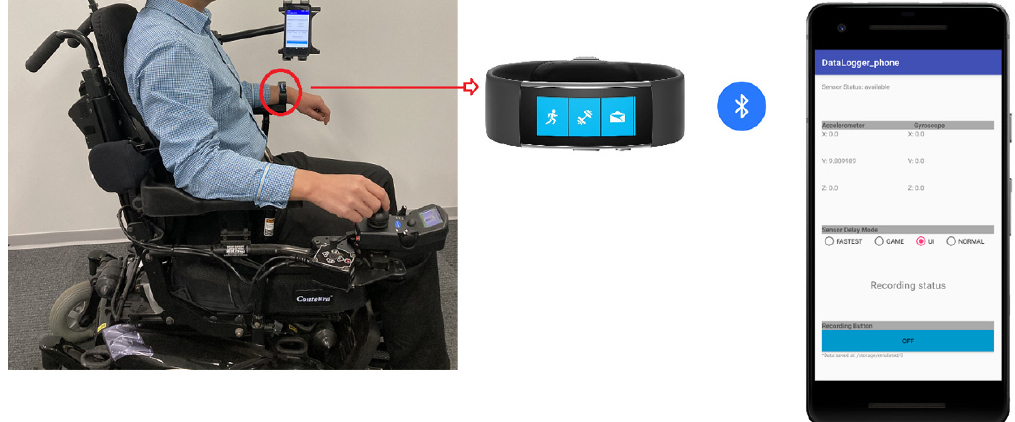
Figure 6. System settings for experimental series 1.